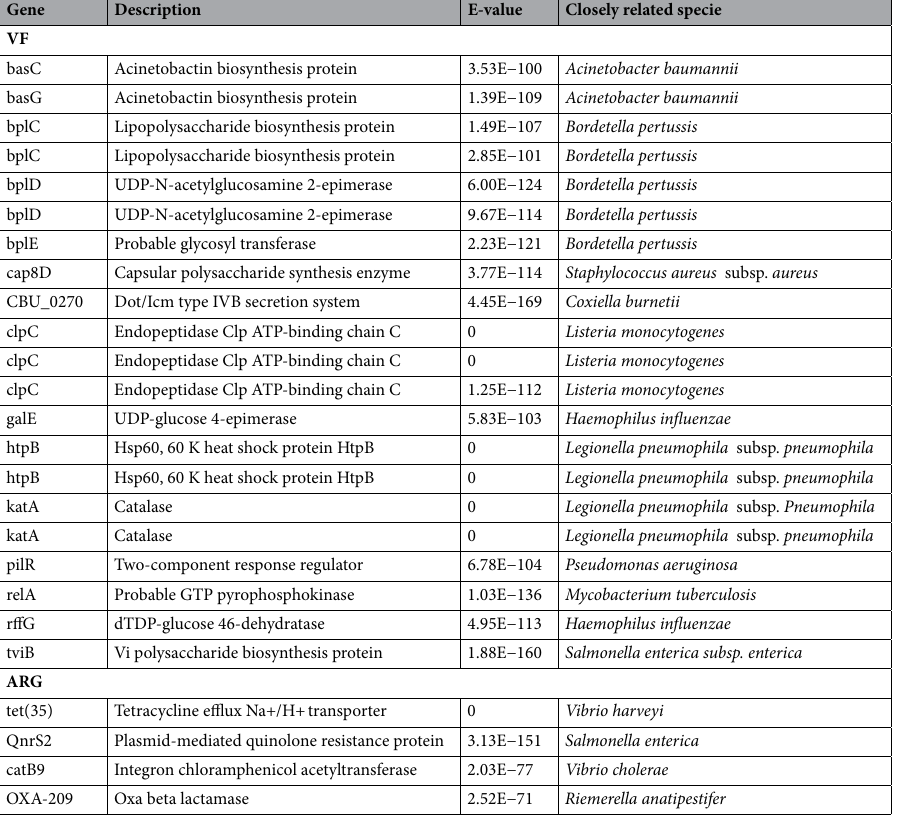
Table 1. Genes coding for virulence factors (VF) and antibiotic resistance genes identified in the genomes associated with C. rogercresseyi